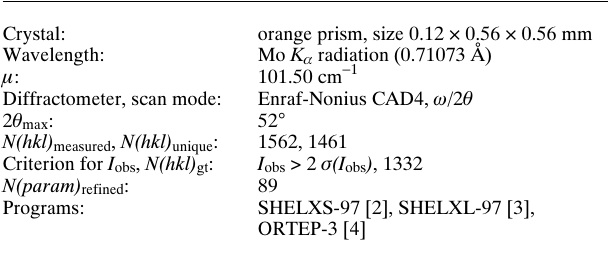
Table 1. Data collection and handling.